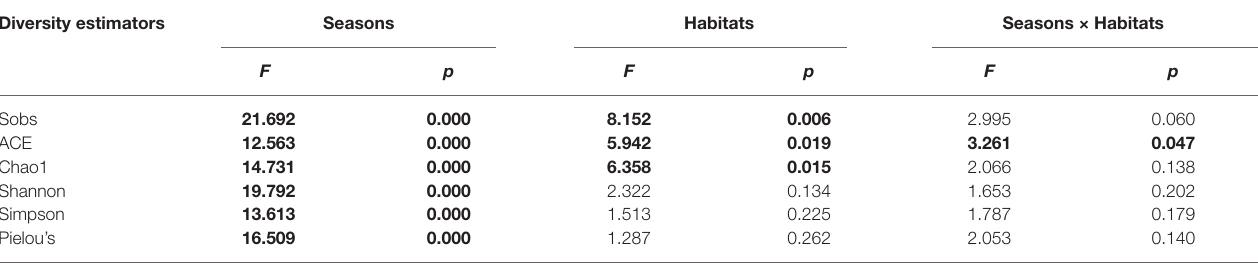
TABLE 1 | Two-way ANOVA showing the effects of seasonality and/or habitats (coast and shelf area) on the α -diversity estimators of operational taxonomic units (OTUs; 97% similarity cut-off) of the whole communities. Diversity